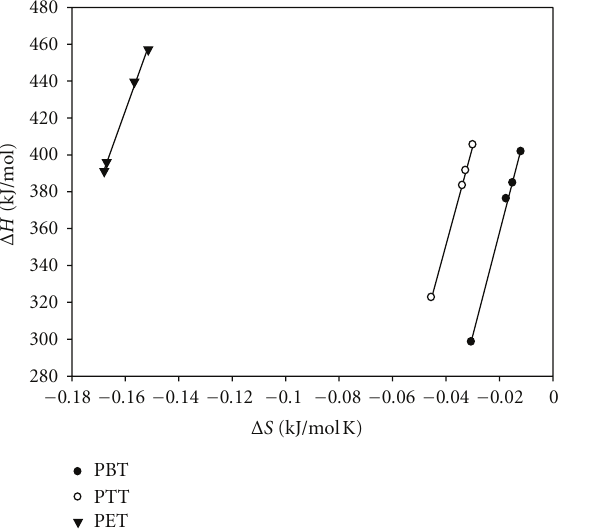
Figure 9: Plot of change in enthalpy as a function of change in entropy for the degradation of di ff erent polyesters in air atmosphere (zone 1).